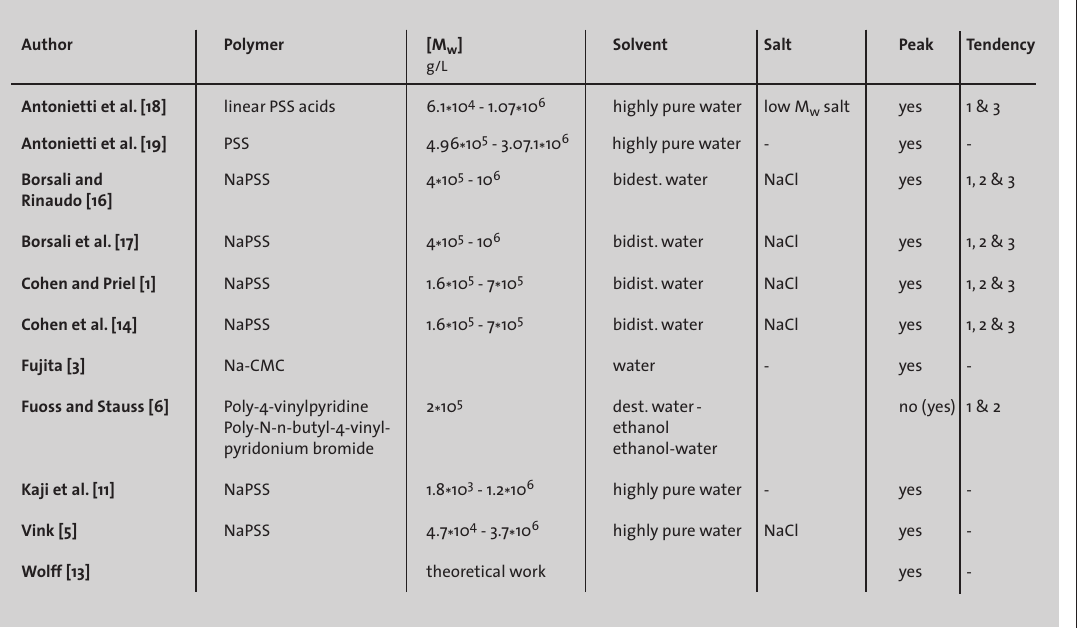
Table 1: The employed polymer solvent system from the quoted literature with reference to the detection of a maximum of the reduced viscosity as a function of the polymer concentration and its tendency (c p,max = polymer concentration at the maxi- mum of the reduced viscosi- ty; In columne Tendency “1” M– ➚ ➾ η ➚ , denotes w red, max M– ➚ ➾ “2” denotes w c p, max ➘ “, while “3” denotes c s ➚ ➾ c p, max ➚ , η red, max ➘